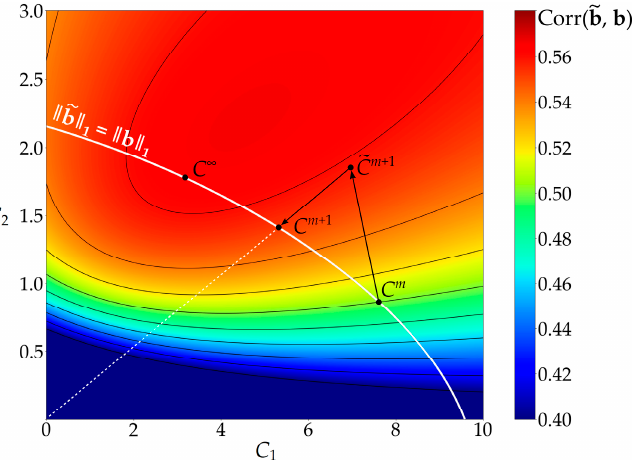
= ‖𝐛‖ (cid:2869) isoline are ~ (cid:2869) b (cid:107) 1 = (cid:107) b (cid:107) 1 isoline